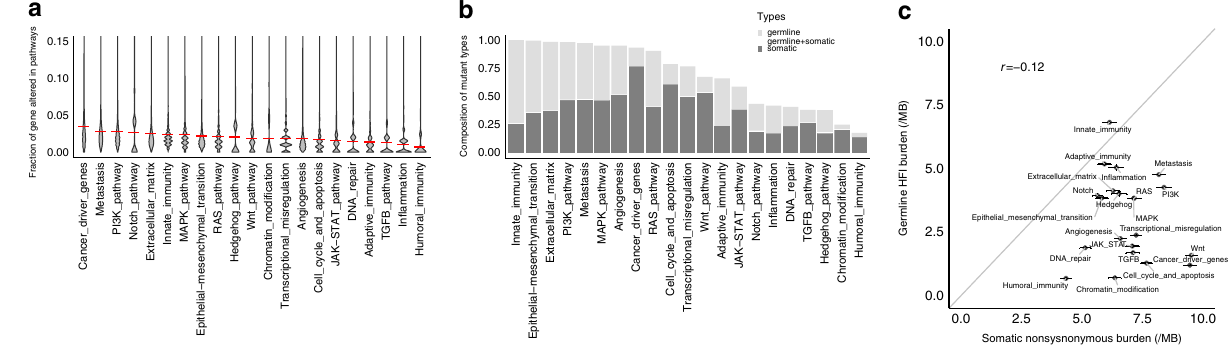
Fig. 4 Contribution of germline variants and somatic mutations to alterations in cancer pathways. a Violin plots show the average fraction and distribution of member genes affected by either germline variants or somatic mutations in 21 pathways. Red lines indicate the average fraction of affected genes. b Average percent of the contribution of germline variant versus somatic mutation to all the affected genes in each pathway across all TCGA samples. c Correlation between average germline variant burden and somatic mutation burden across the cancer hallmark pathways. Error bars show the standard error. Vertical error bars (for the germline HFI burden/MB) are too small to be TGFbeta pathways. Figure 4c shows the correlation between average germline variant burden and average sM burden for the 21 pathways across all cancer types.